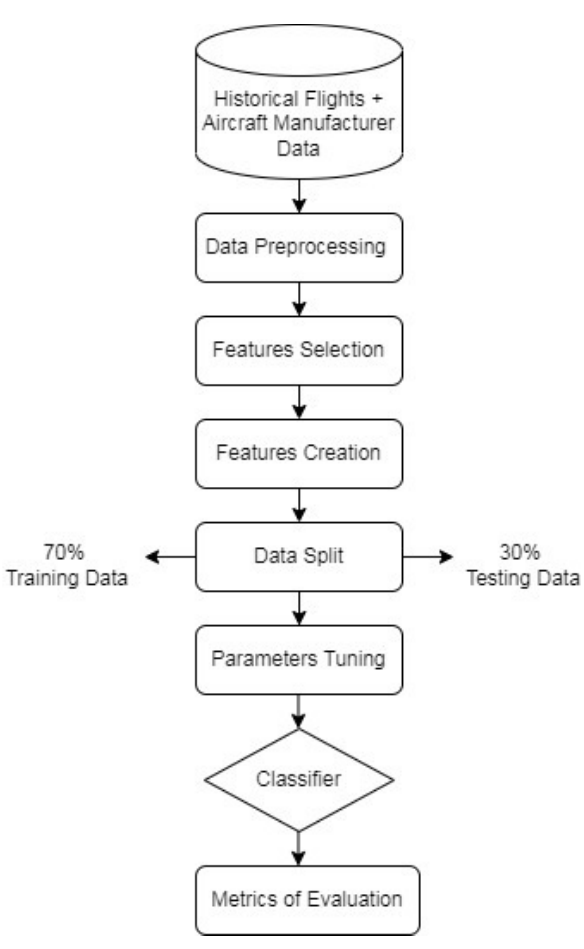
Fig. 2. Flowchart of the proposed